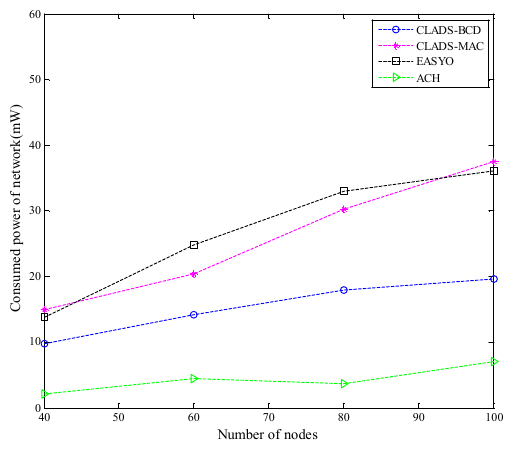
Figure 2. Consumed power of the network with varying number of